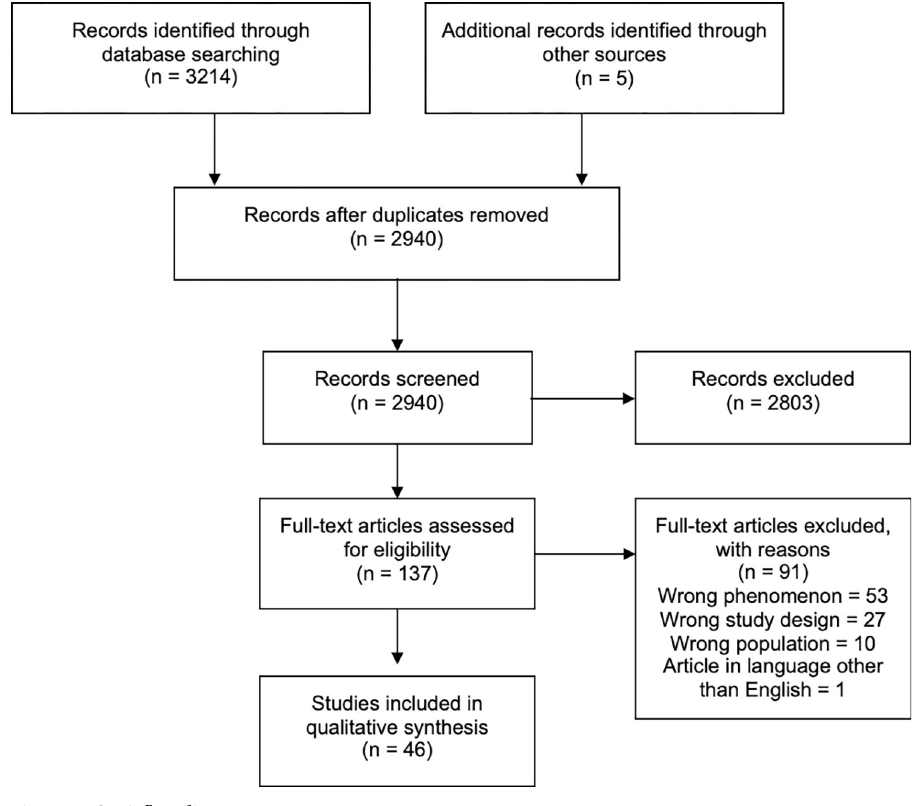
Fig 1. PRISMA flow